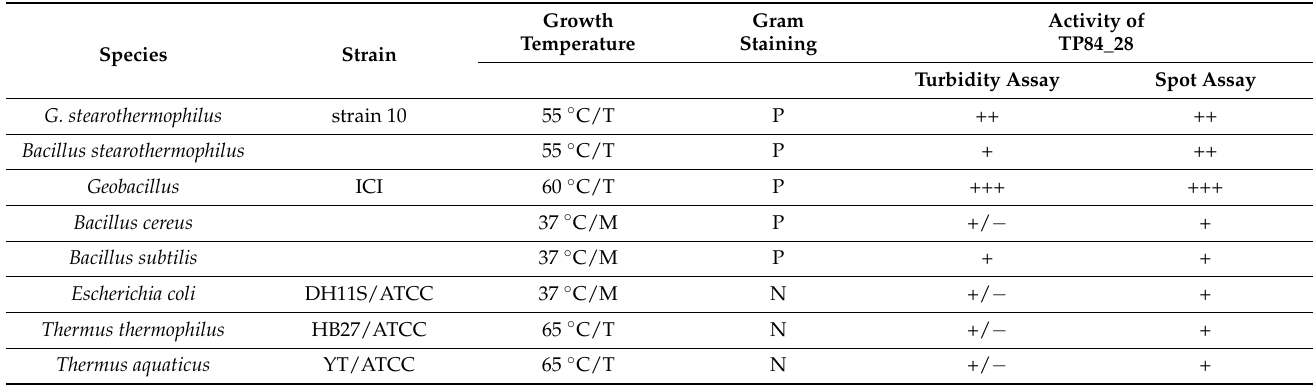
Table 2. Relative lytic activity of recombinant TP-84_28 endolysin on various bacterial substrates.